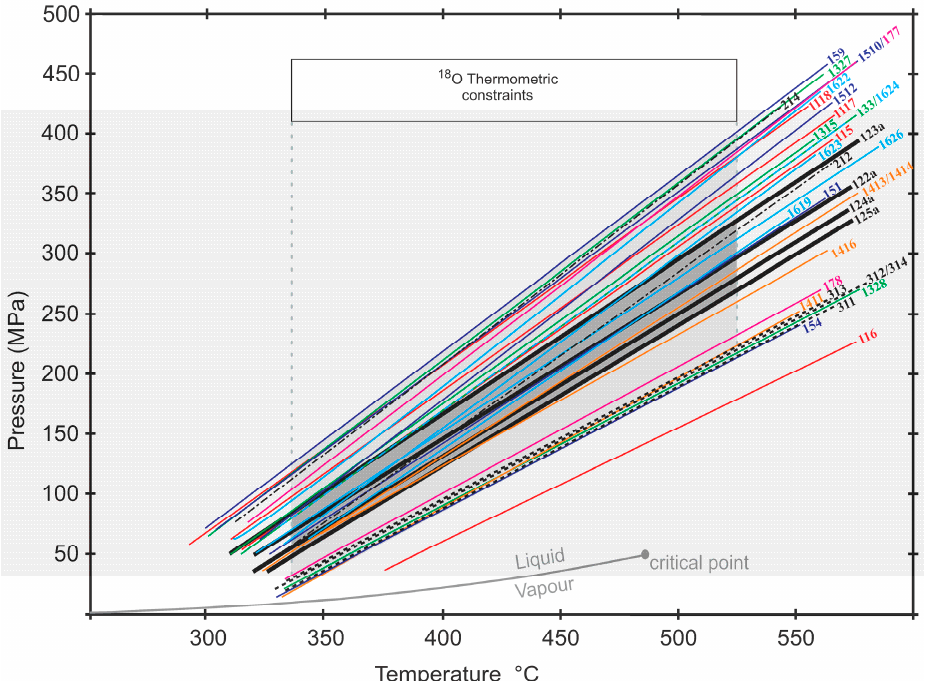
Figure 11. Pressure–temperature diagram showing all of the individual FI isochores for the FIT-1, 2, and three Poona fluid inclusions hosted in emerald. The pressure–temperature constraints from the stable isotope thermometry combined with all of the isochores and the FIA displaying the least amount of post-entrapment-changes (Table 3, FIT-1, FIA-2) are shown in light and dark grey shaded areas respectively. The individual isochores are labelled with the first digit representing the FIT, the second digit representing the FIA, and the fourth and/or third digits representing the individual FI number from Table 3. The liquid–vapour curve for a 12 wt % NaCl–H 2 O fluid, derived from the data of [36], is shown in grey with grey text.